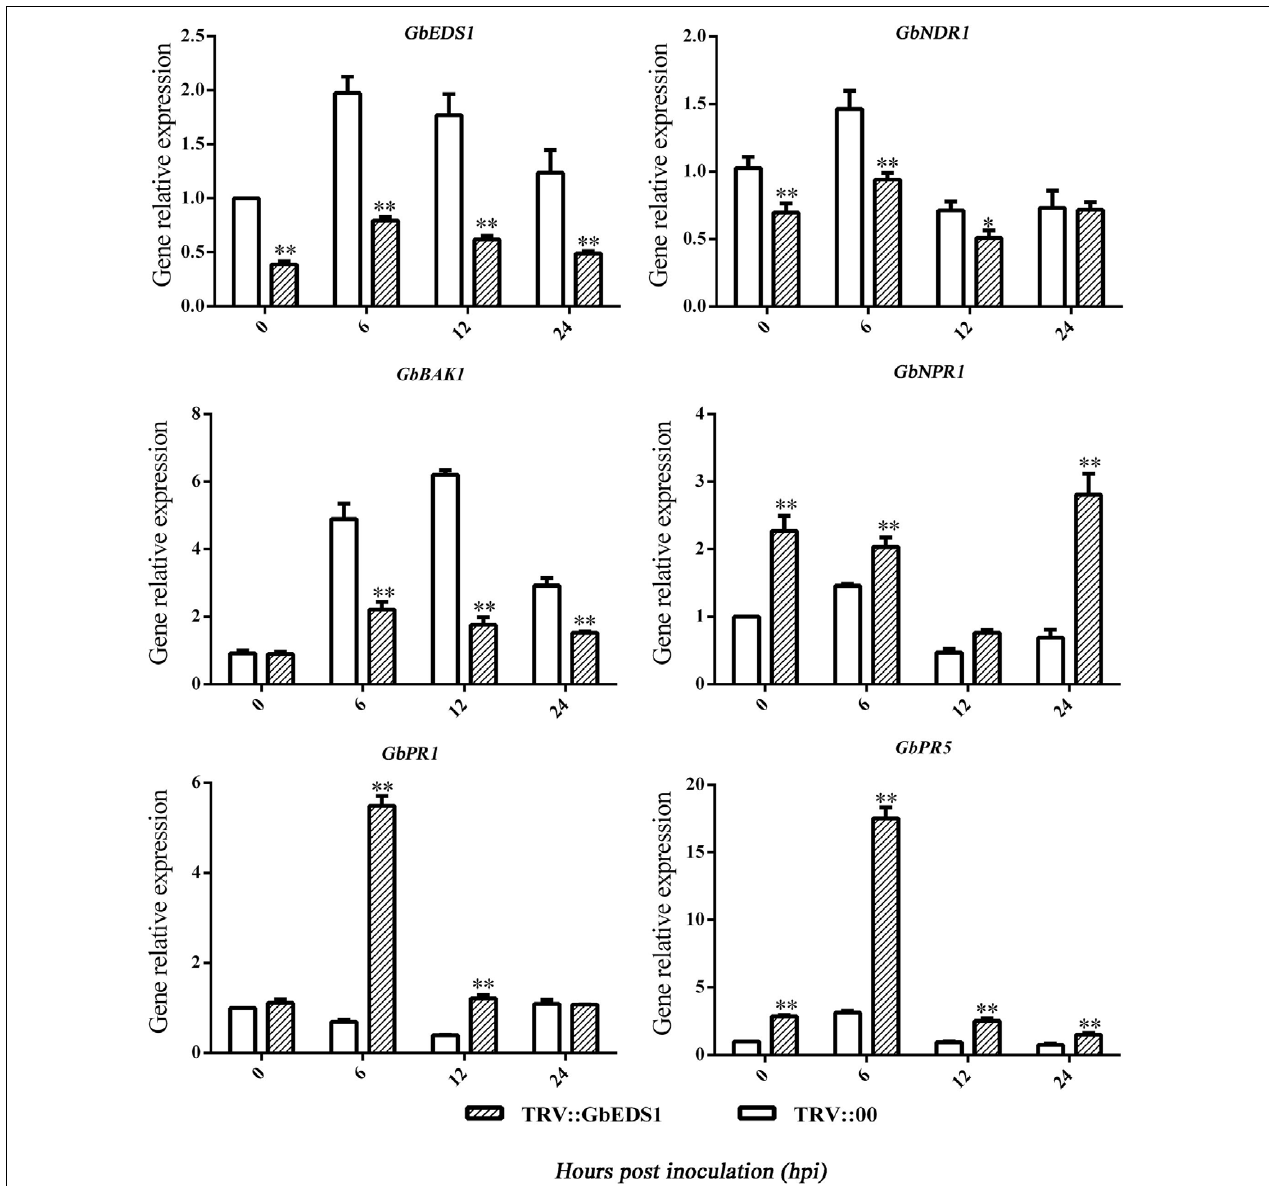
FIGURE 9 | Detection of SA signaling pathway-related genes and defense related genes. qRT-PCR analysis the expression of genes ( EDS1 , NPR1 , NDR1 , BAK1 , PR1 , and PR5 ) in silenced cotton. Error bars represent the standard deviation for three independent experiments, and three technical replicates were analyzed; asterisks indicate statistically significant differences, as determined by the Student’s t -test ( ∗ P < 0.05, ∗∗ P <